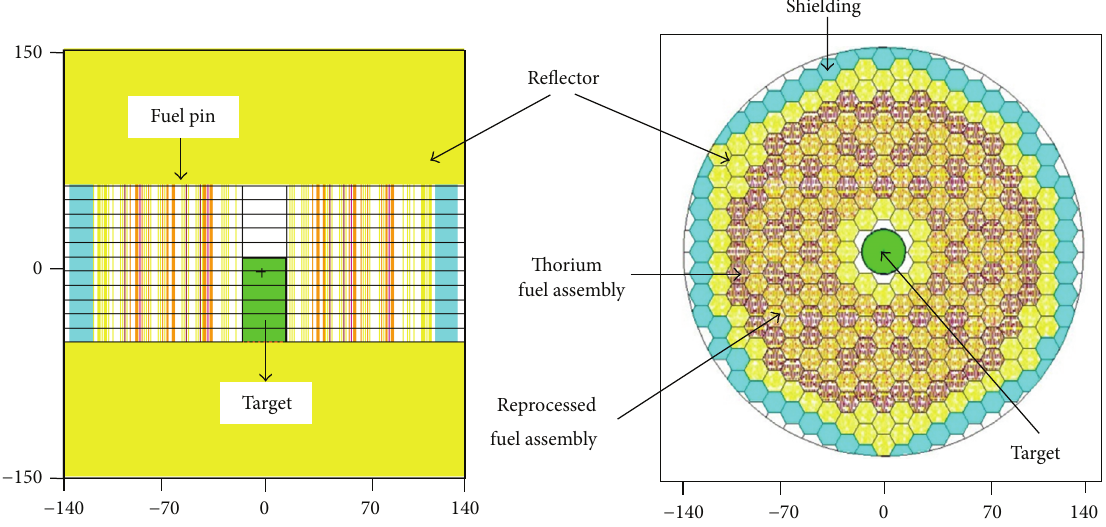
Figure 1: Vertical and horizontal sectional views of the seed-blanket ADS design (scale is given in cm).